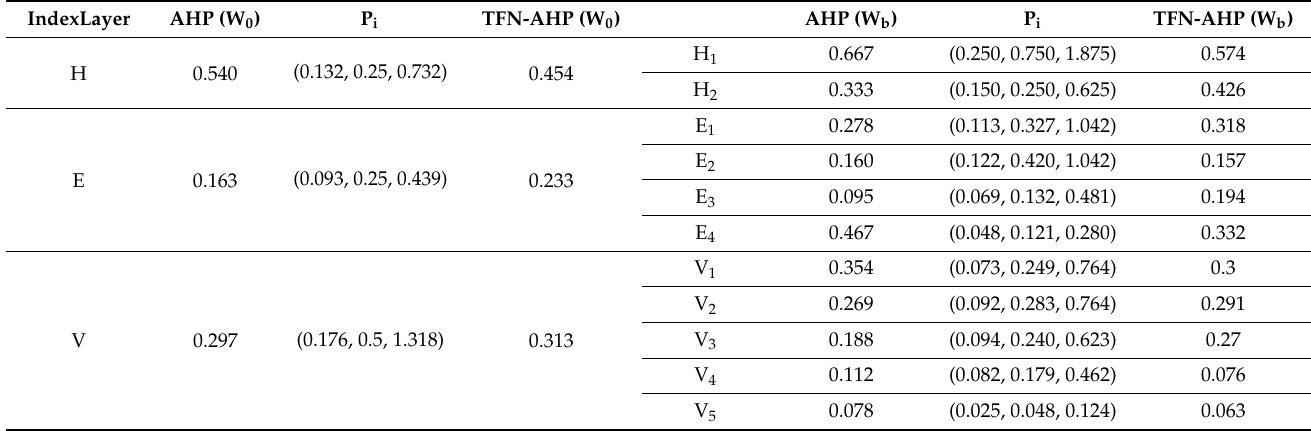
Table 3. AHP and TFN-AHP process weight.